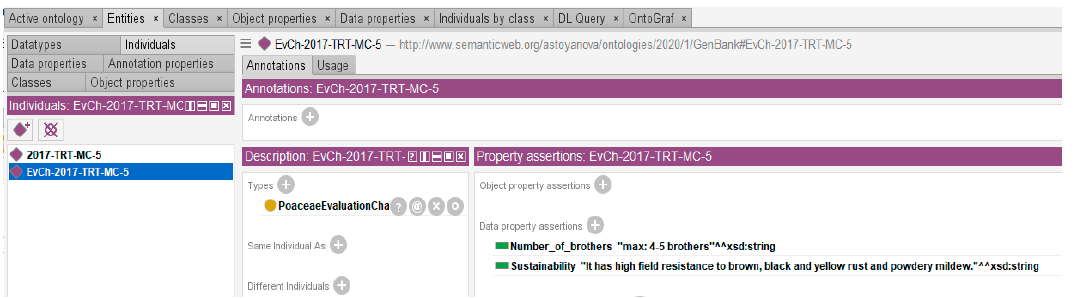
Figure 10. Descriptor and Evaluation_characteristics classes.